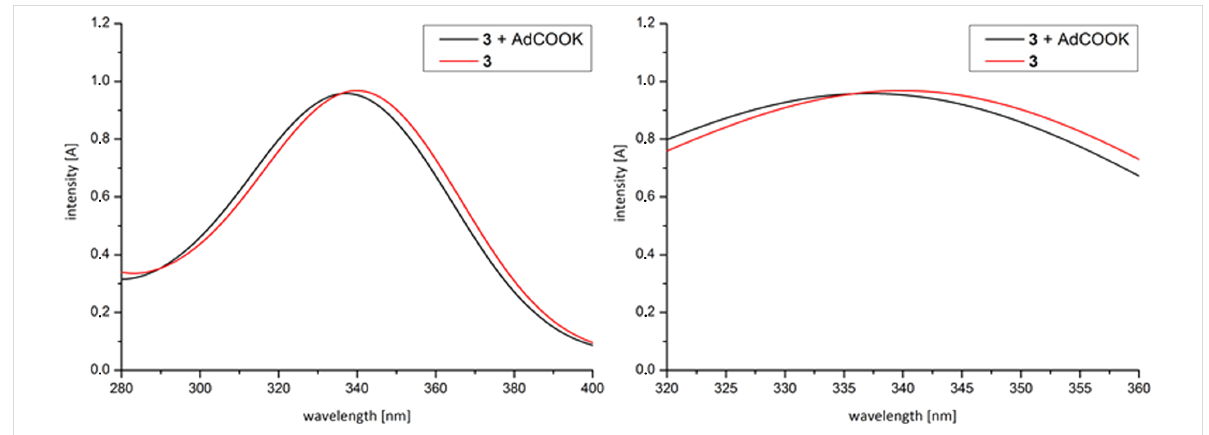
Figure 2: UV–vis spectrum of 3 (4 × 10 − 4 M) with and without a 10-fold excess of potassium adamantane-1-carboxylate.